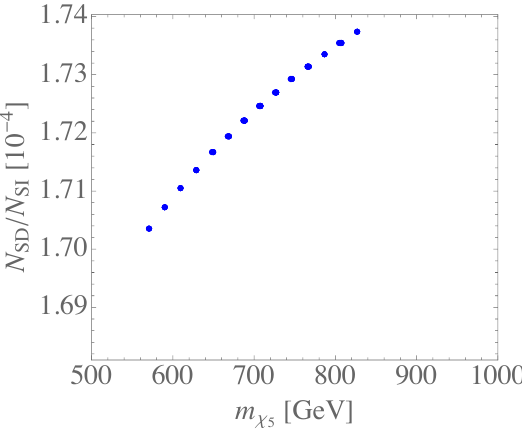
Figure 4 . Event number ratio of SD contribution to SI contribution in DM- 131 Xe